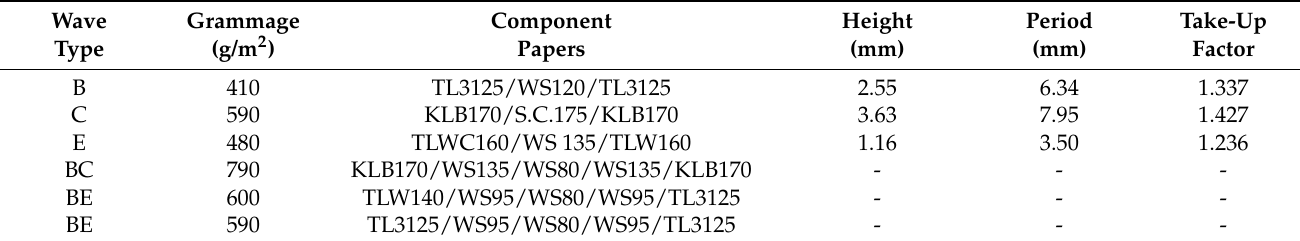
Table 1. Component papers and geometry of the corrugated boards.